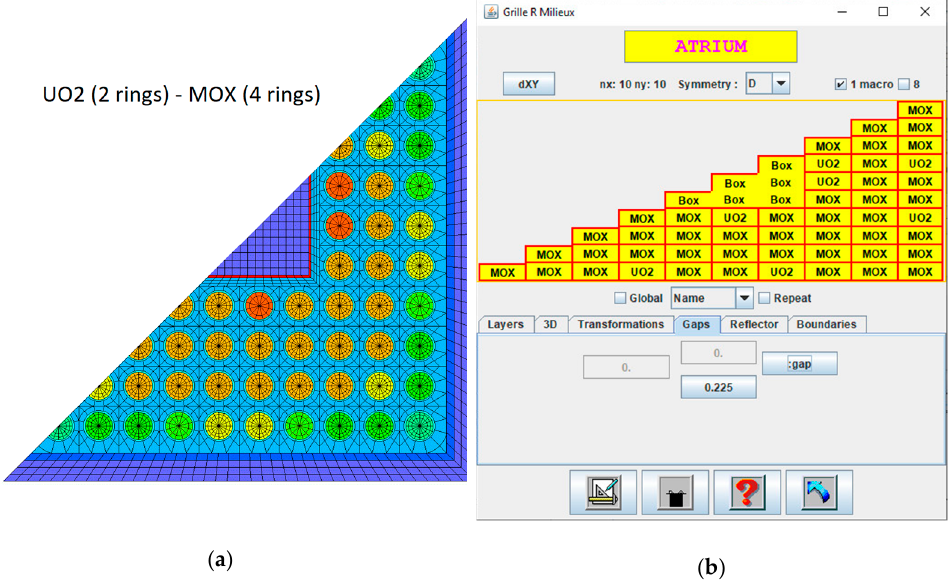
Figure 4. ATRIUM-10 (10-9Q) BWR FA with diagonal symmetry by Silène. ( a ) Flux distribution color map. ( b ) Component dialog box.